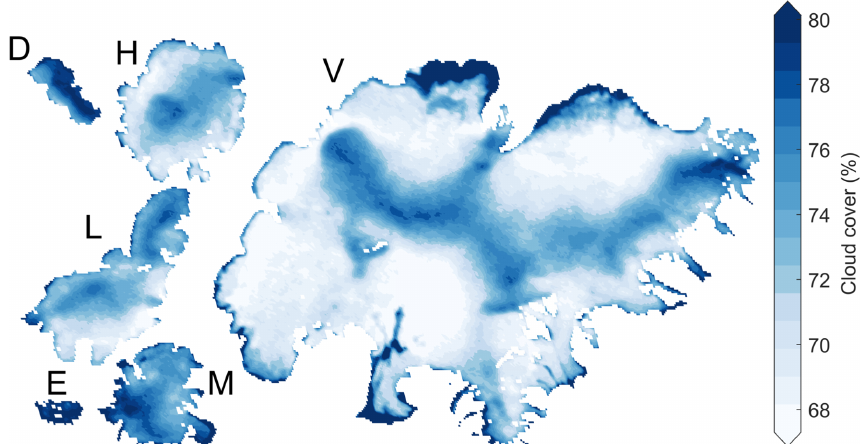
Figure 3. Average cloud cover for the main Icelandic ice caps for the extended melt season from May to September each year from 2000– 2019 (average: